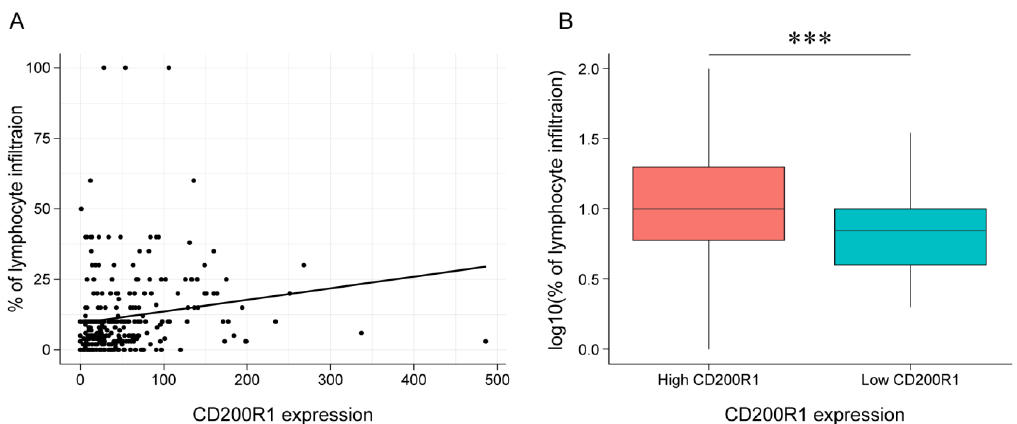
Figure 6. CD200R1 mRNA expression and tumor lymphocyte infiltration in the TCGA HNSCC. A plot for correlation analysis ( A ). Pearson correlation calculation was performed for linear correlation. A plot for mean comparison stratified based on CD200R1 mRNA expression ( B ) *** p < 1 × 10e − 3 .